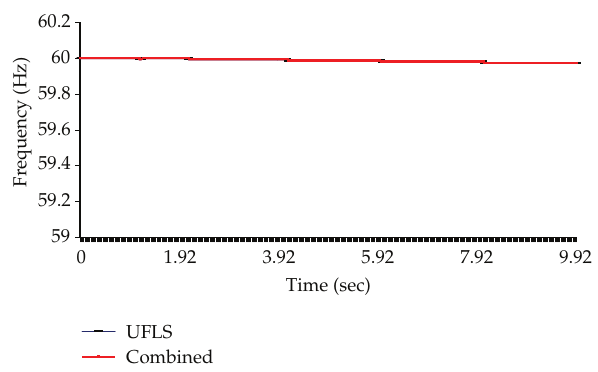
Figure 16: Average frequency responses when both schemes are